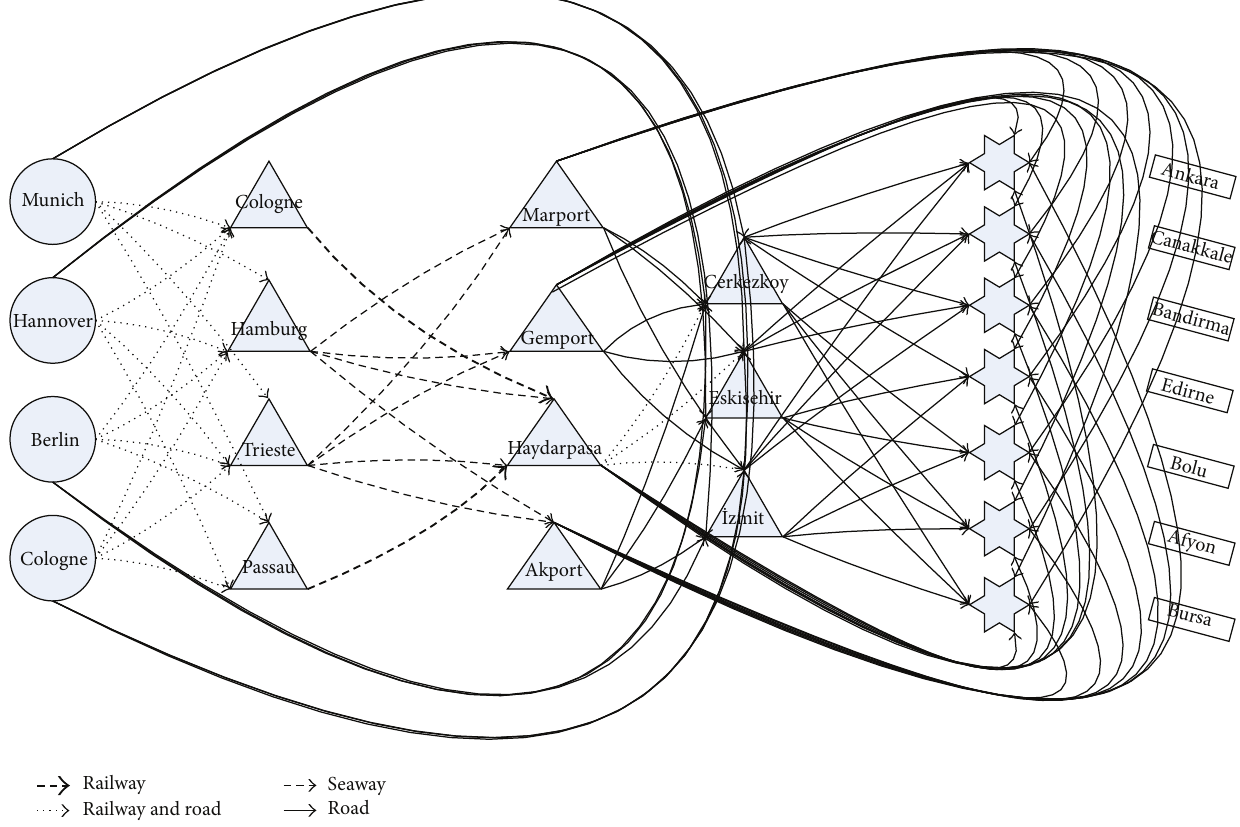
Figure 5: General structure of the current transportation